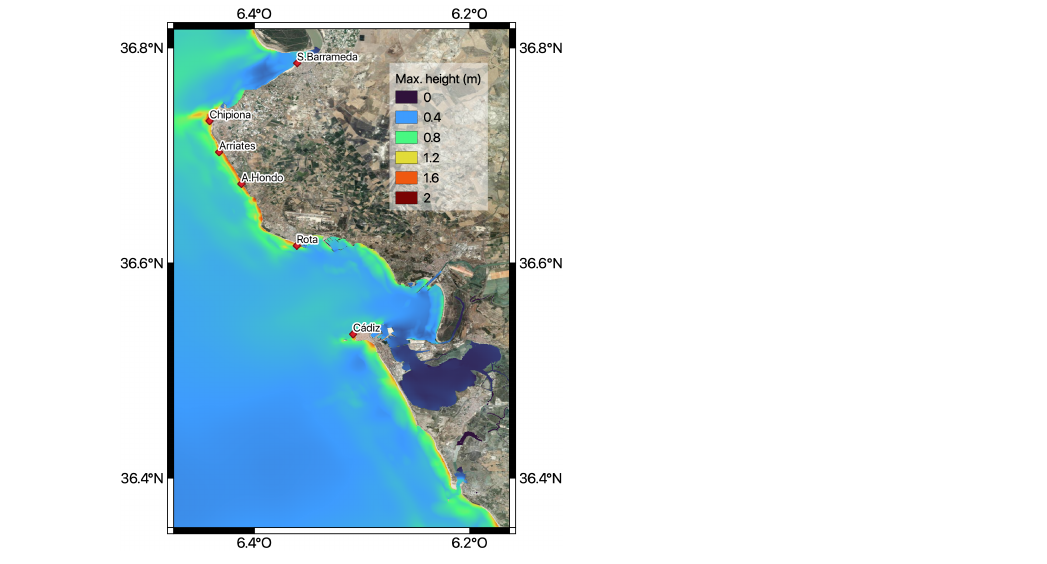
Figure 6. Maximum height for the reference event at segment CA01. The spatial resolution is 40